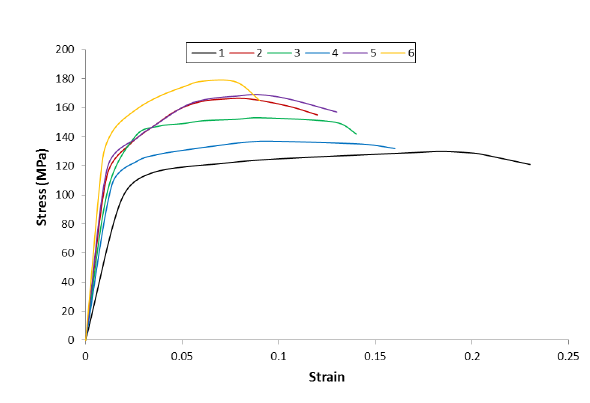
Figure 9: Typical stress-strain curves of all test samples.